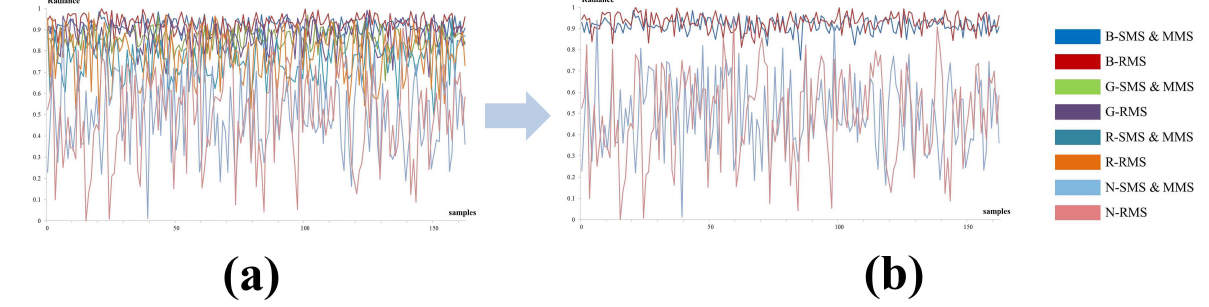
Figure 7. Band selection of high-resolution images. ( a ) The image consists of four bands (blue, green, red, and near infrared). The RMS has mixed spectral features with the other two types and quantities of redundant information that exist. ( b ) Little redundant information exists when there are only two bands left (blue and near infrared), which means less complexity and calculations of the algorithm.